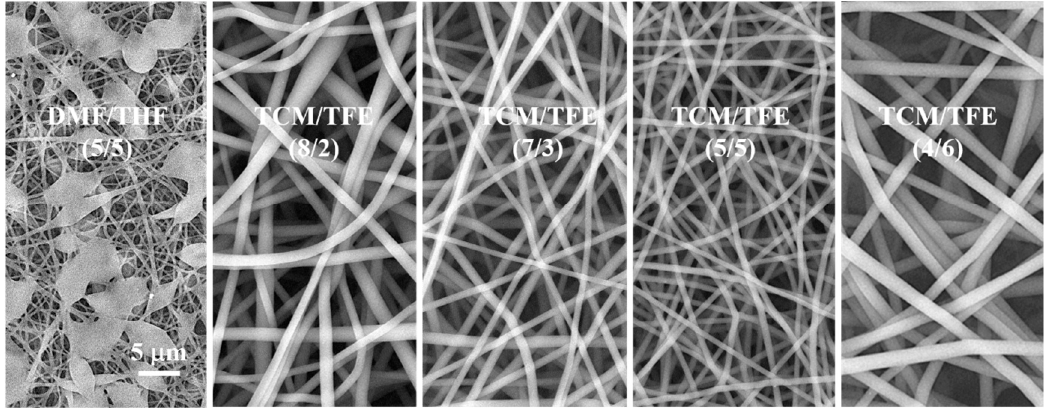
Figure 2. SEM images of electrospun TPU nanofibers from DMF/THF and TCM/TFE solvent systems at different ratios of solvents (5% w / v ).